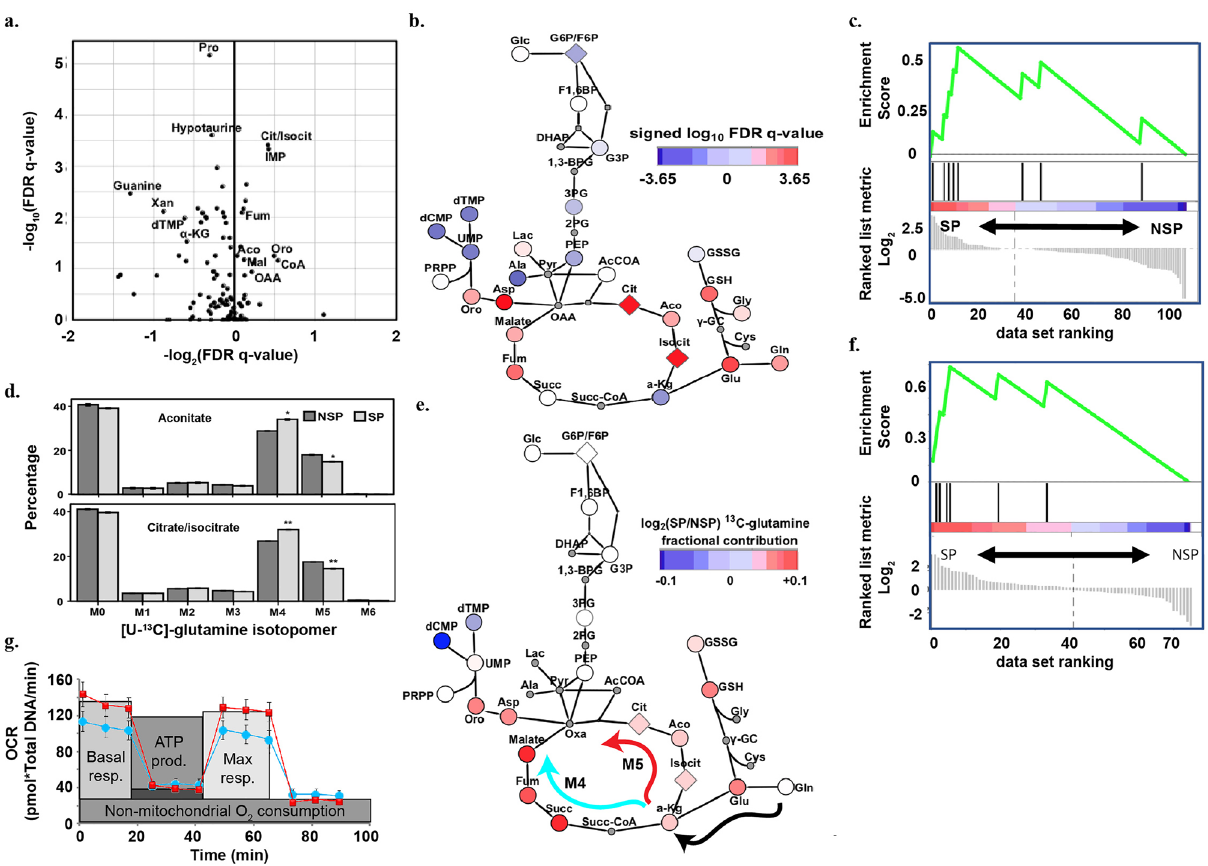
Figure 2. Glutamine-derived TCA cycle is upregulated in SP population. ( a ) Volcano plot of intracellular metabolite pool sizes. Data represents average weighted log 2 fold change (SP/NSP) and FDR-corrected q-value from three independent experiments. ( b ) Metabolic pathway map representing signed log 10 FDR q-value on a color scale for intracellular pool sizes of metabolites comparing SP and NSP populations. Metabolites that were not measured are shown as small circles with grey color. Isomers that were not resolved by LC–MS are shown as diamonds. ( c ) Enrichment of TCA cycle pathway with MSEA analysis of intracellular metabolites pool sizes of SP and NSP populations. Metabolites were ranked based on the signed log 10 FDR q-value comparing SP and NSP populations. ( d ) Labelling patterns of aconitate and citrate/isocitrate from [U- 13 C]-glutamine. M-values reflect the number of 13 C (5 total) remaining after α-ketoglutarate is modified in the TCA cycle. M4 is associated with conversion of α-ketoglutarate to succinyl-CoA, giving up one heavy carbon in the reaction, and is coupled to oxidative phosphorylation. M5 is associated with carboxylation of α-ketoglutarate to become isocitrate and retaining all 5 13 C atoms. This reversal of TCA is also known as “backwards” flux. * denotes p-value less than 0.0002, ** denotes p value less than 0.00004 by Student’s t test. Results are means of three biological replicates with small error bars; raw data are provided in Supplemental Table S1. ( e ) Metabolic pathway map representing log 2 fold change of SP/NSP on a color scale for [U- 13 C]-glutamine fractional contribution. The arrows show the two paths, M4 forward flux (blue arrow) and M5 backward flux (red arrow) that [U- 13 C]-glutamine can take after becoming α-ketoglutarate and entering TCA cycle (black arrow). Metabolites that were not measured or had less than 1% fractional contribution are shown as small circles with grey color. Isomers that were not resolved by LC–MS are shown as diamonds. ( f ) Enrichment of TCA cycle pathway with MSEA analysis of [U- 13 C]-glutamine fractional contribution of SP and NSP populations. Metabolites were ranked by the log 2 ratio of SP/NSP [U- 13 C]-glutamine fractional contribution. ( g ) OCR in SP (red) is higher than NSP (blue) in the Seahorse analysis corresponding to the expected higher OxPhos metabolism of SP cells. *( b ) and ( e ) were drawn using cytoscape: version 3.5.1. https:// cytos cape. org/ roadm ap.